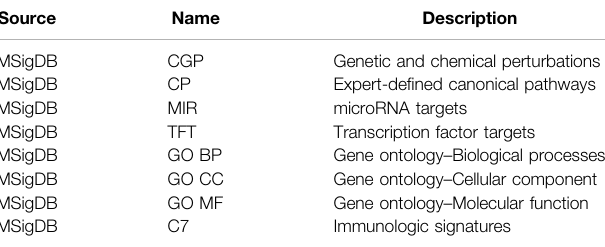
TABLE 1 | Pathway databases used for Gene2Drug